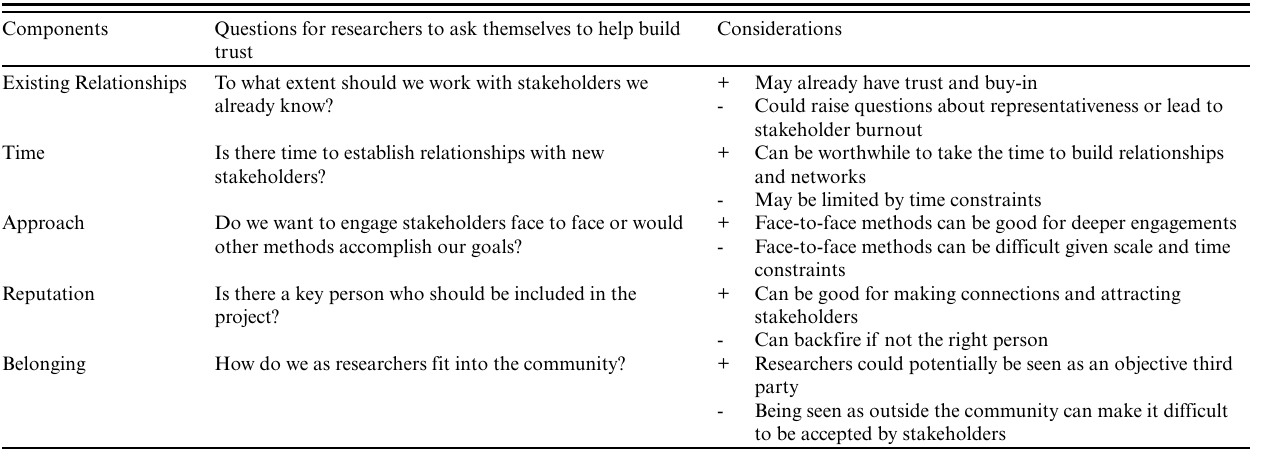
Table 5. Questions and considerations to guide researchers in building trust, derived from the experiences of researchers leading 12 ecosystem services research case studies.